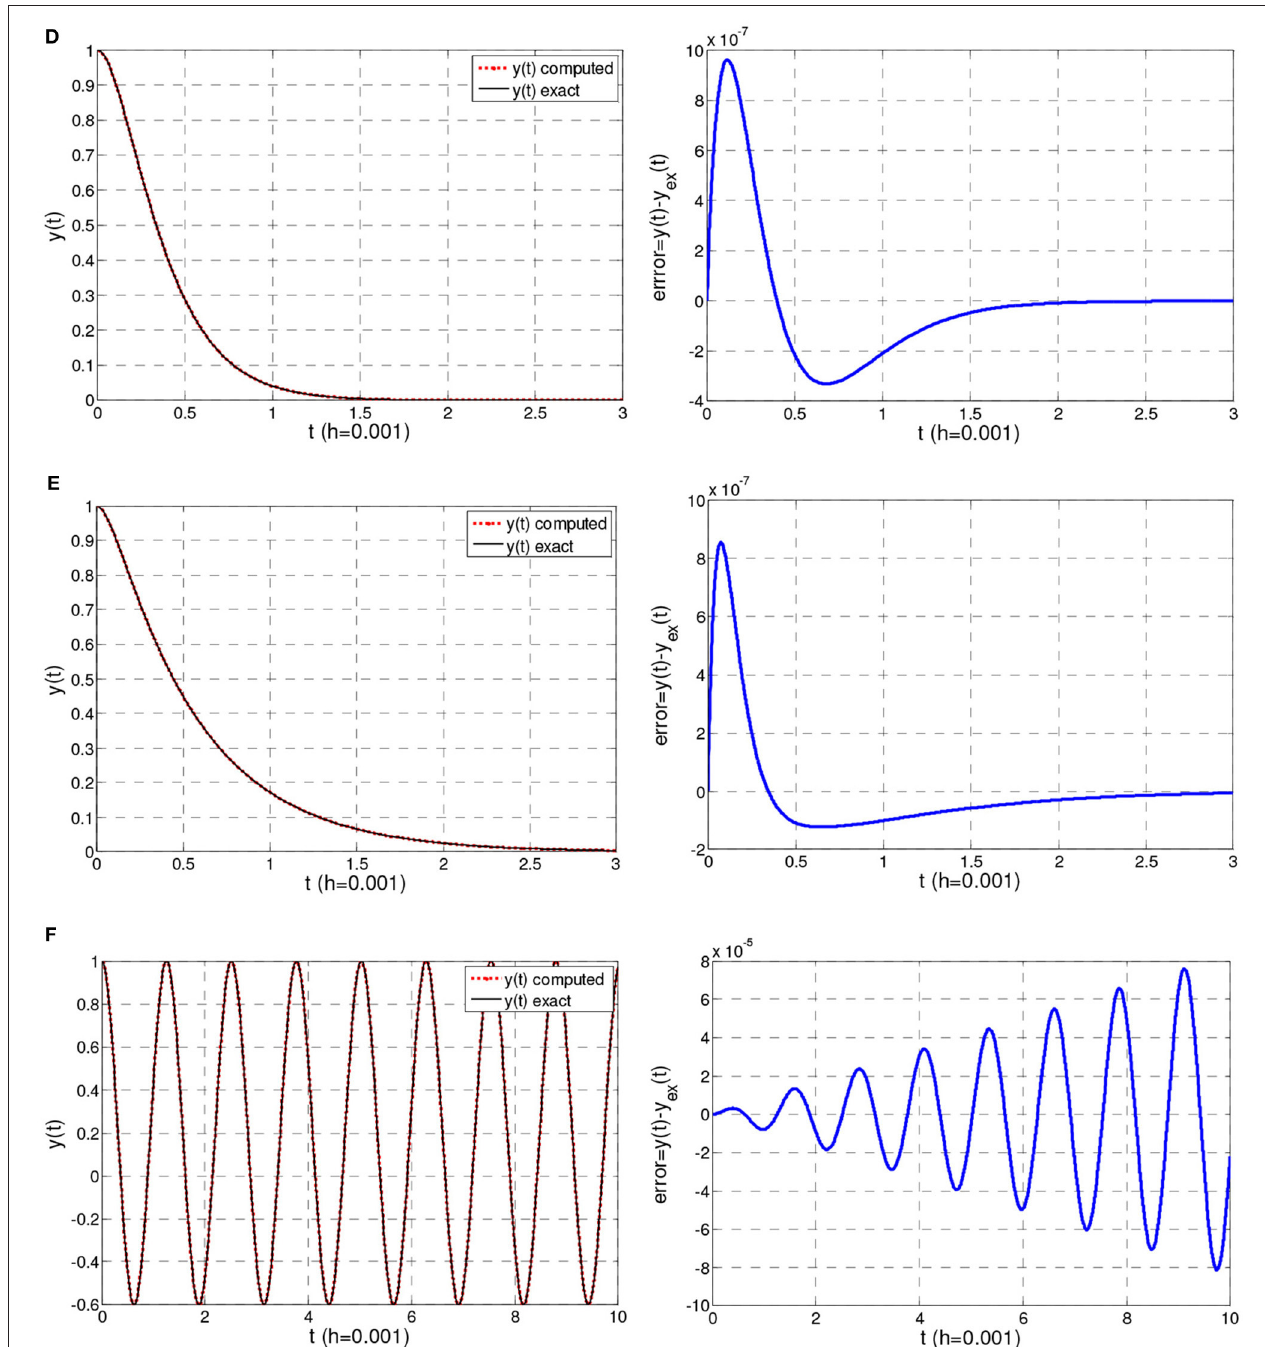
FIGURE 1 | (A) Solution in Example 1, case (i). (B) Response for long duration in Example 1, case (i). (C) Solution in Example 1, case (ii). (D) Solution in Example 1, case (iii). (E) Solution in Example 1, case (vi). (F) Solution in Example 1, case (v).